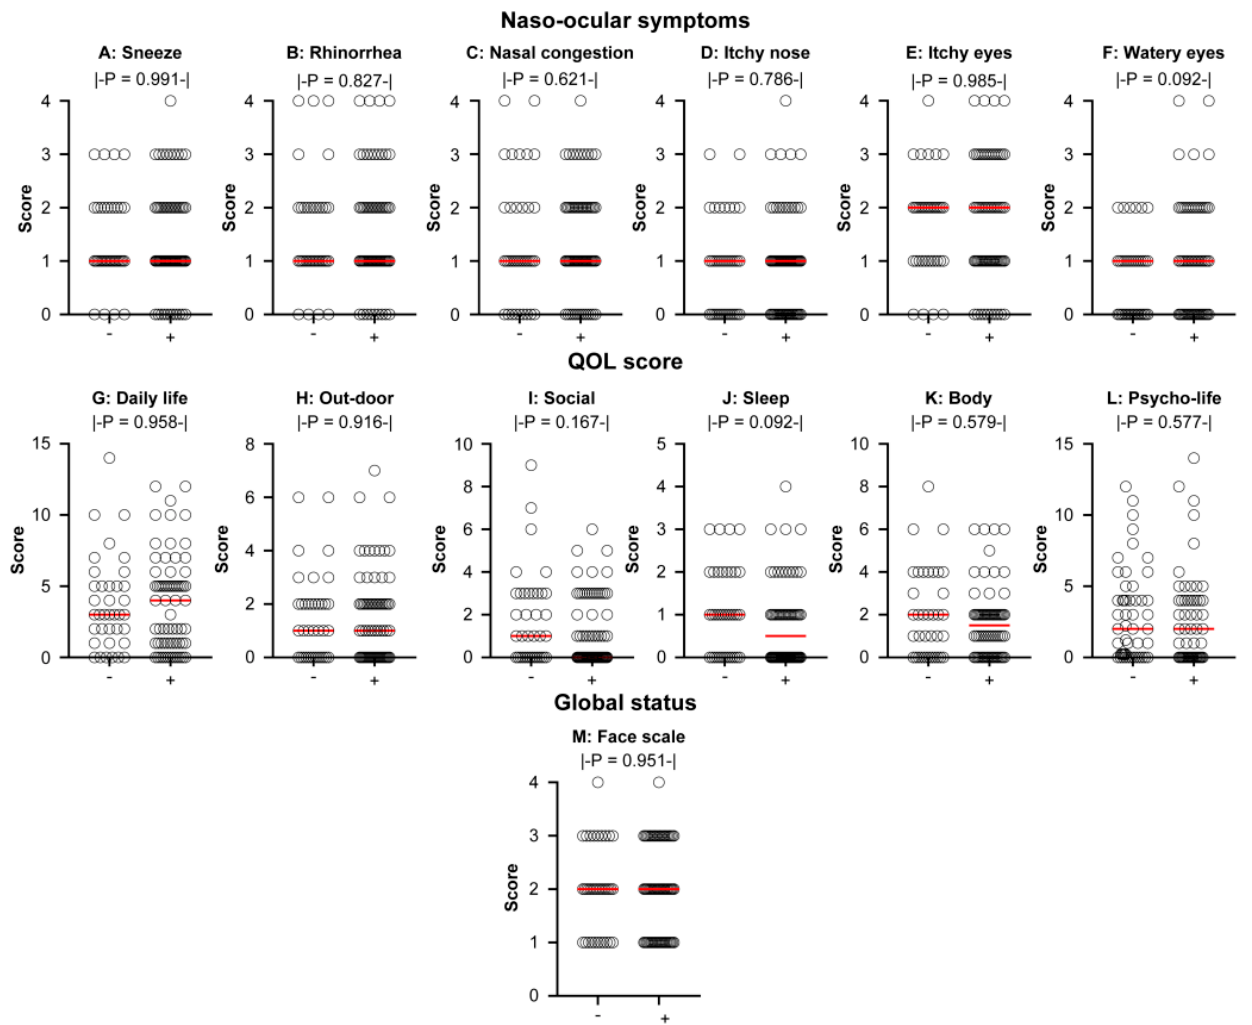
Figure 3. Comparison of the severity in the naso-ocular symptoms, QOL score, and global status